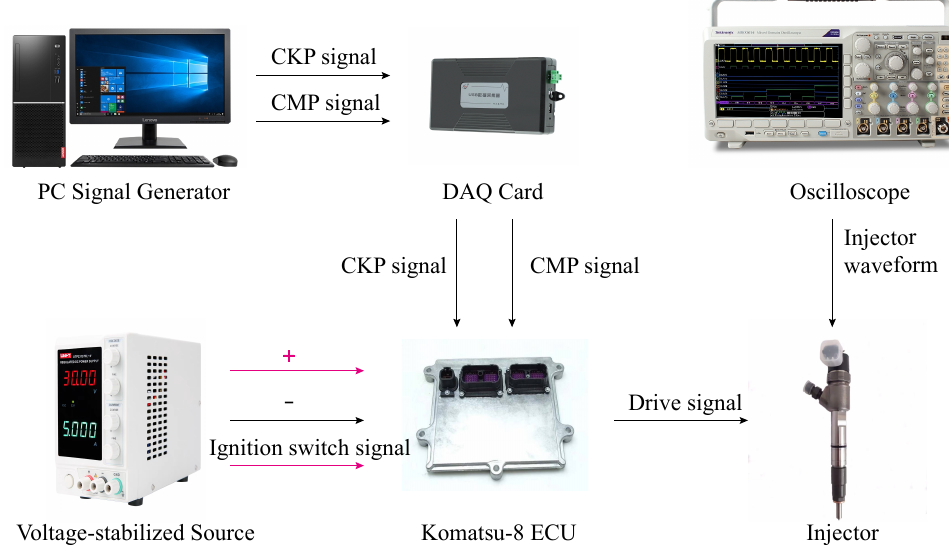
Figure 23. Setting up experimental environment. Collecting the injection pulse signal output by the ECU with an oscilloscope can detect whether the ECU can recognize the simulated CKP and CMP signals. The ECU can recognize the signal normally and issue the injection instruction after the actual test. The injection waveform output of the ECU is shown in Figure 24. The PWM wave in the figure below is the injection duration.